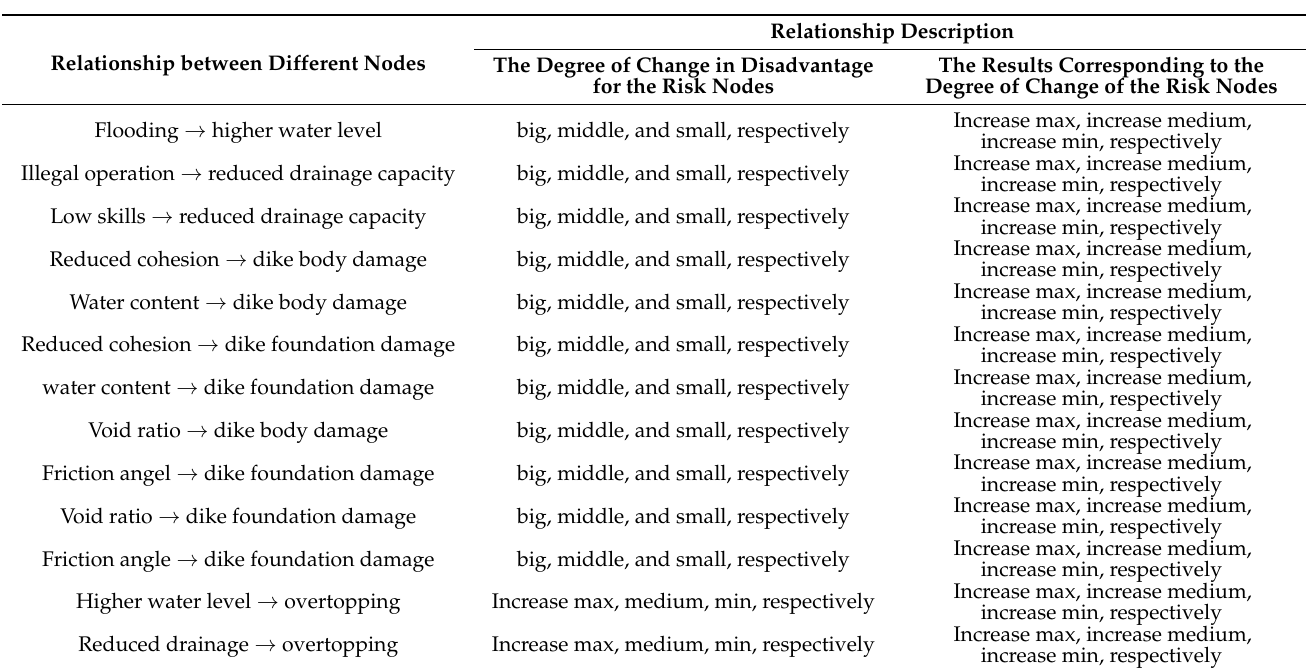
Table 3. The fuzzy relationship of different risk